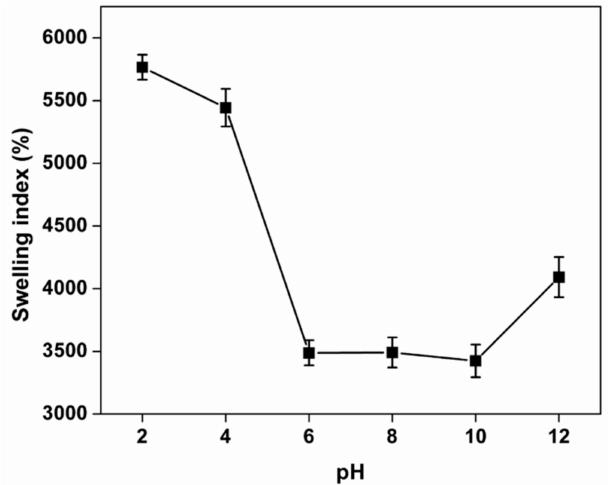
Figure 5. Effect of pH on the swelling index of Kg-Ch sponge.